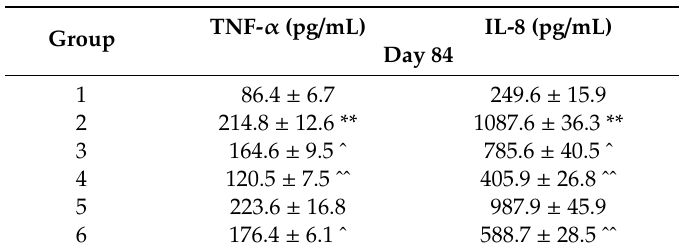
Table 5. E ff ects of HFD and AP-NHm mixture on TNF- α and IL-8 blood concentration on Day 84. Group 1: standard diet + vehicle; group 2: HFD + vehicle; group 3: HFD + AP-NHm 1 co-treatment; group 4: HFD + AP-NHm 2 co-treatment; group 5: HFD + AP-NHm 1 post-injury; group 6: HFD